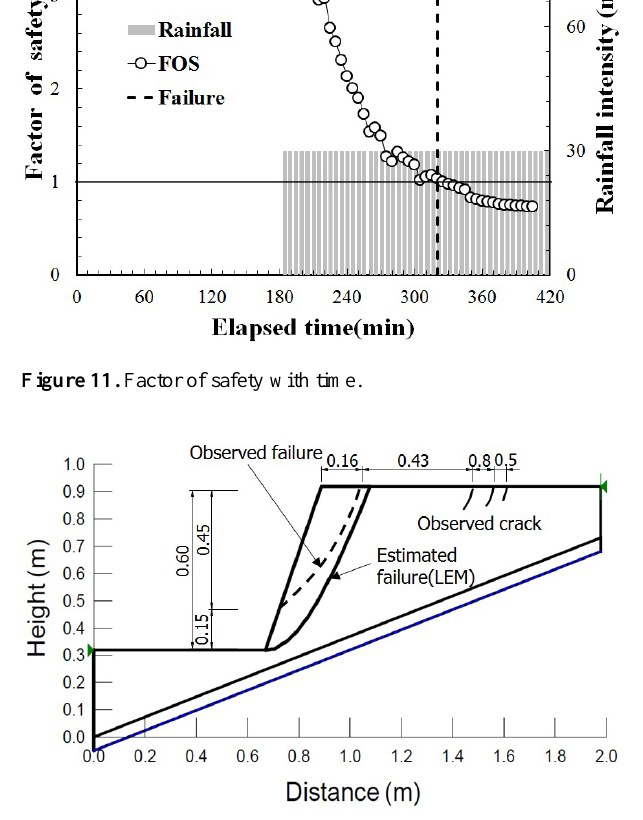
Figure 12. Comparison of failure